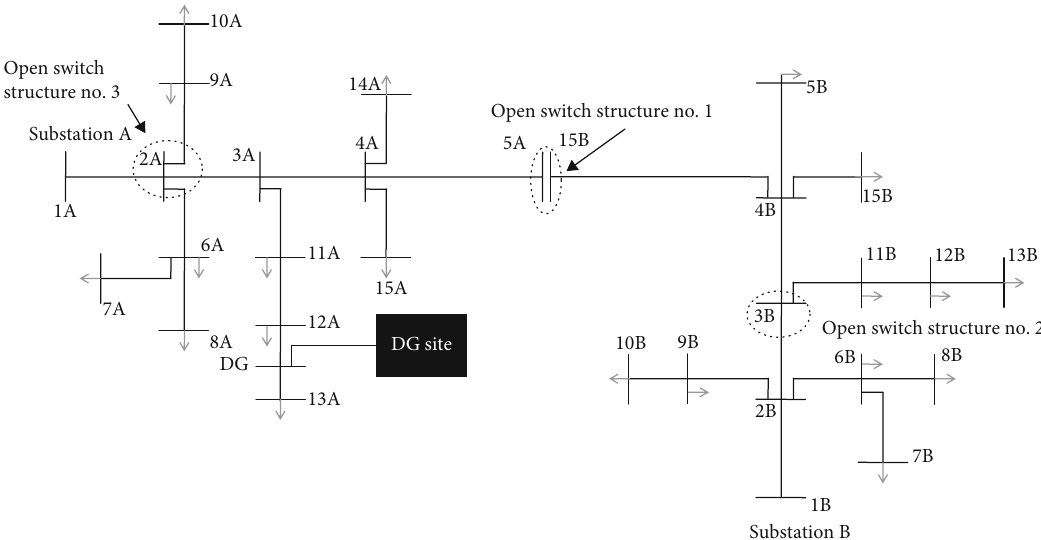
Open switch structure no.